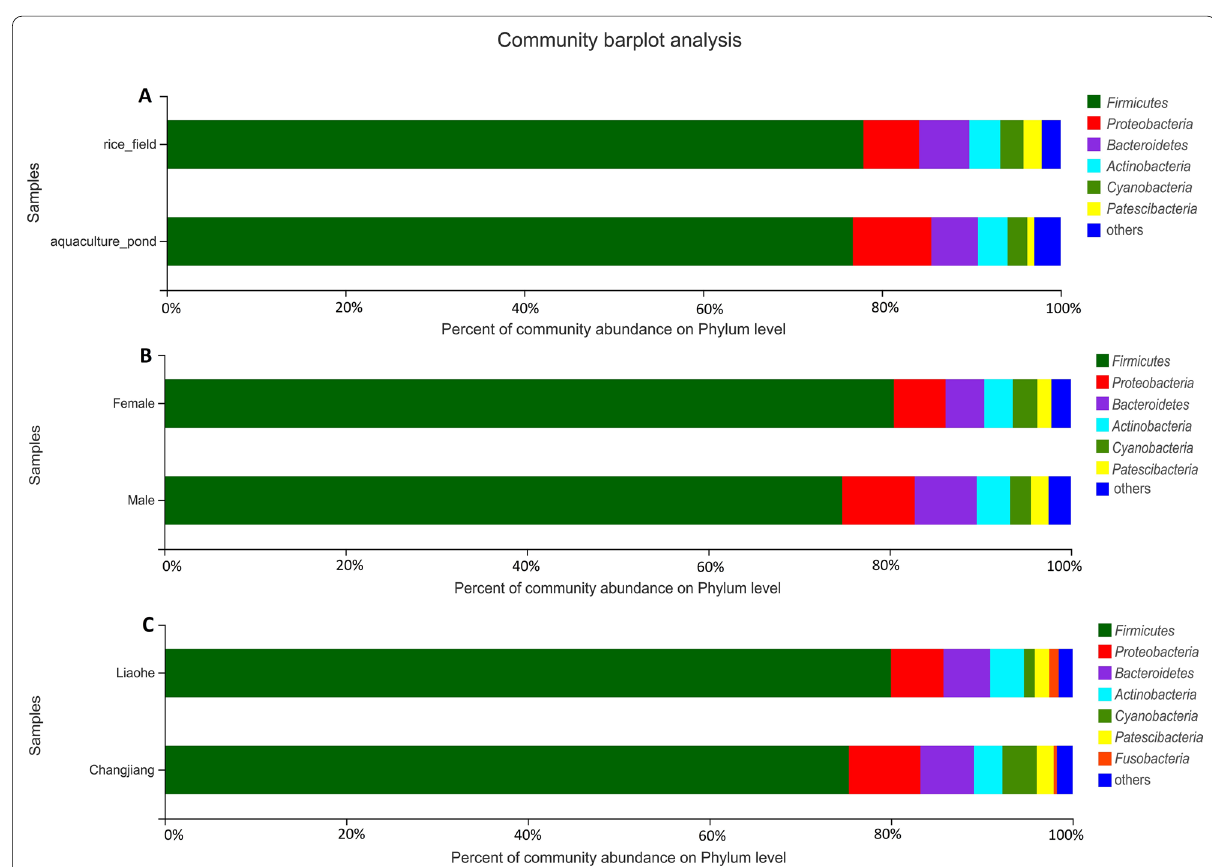
Fig. 2 Bacterial community structure of the intestinal sample groups at the phylum level. Field and pond, intestinal bacteria in Chinese mitten crabs raised in the rice–crab co-culture system (n Liaohe and Changjiang, two varieties of Chinese mitten crab (n